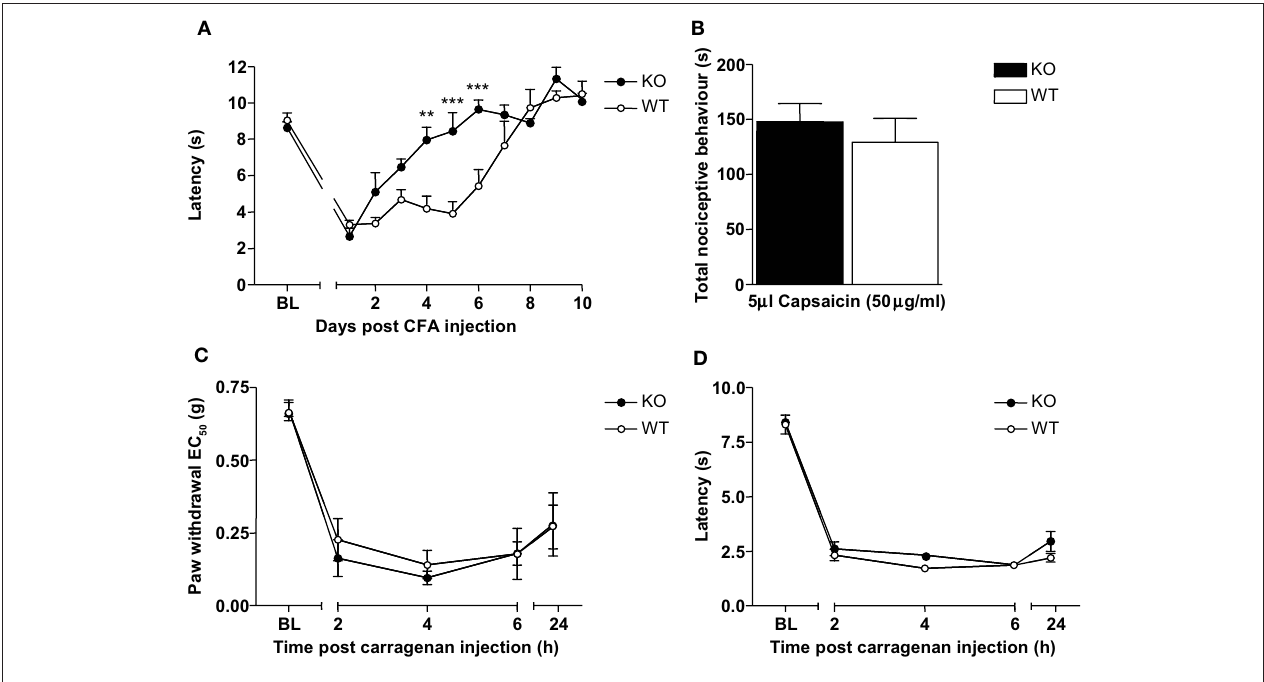
FIGURE 3 | Glra3 − / − mice display attenuated CFA behaviour, but show no differences in other infl ammatory models. (A) Paw withdrawal latencies following unilateral intraplantar CFA (20 µl) were signifi cant versus contralateral responses for wild-type mice days 1–6 and days 1–3 for Glra3 − / − mice ( p < 0.001). Paw withdrawal latencies of Glra3 − / − mice were signifi cantly different from wild- type mice at days 4 ( p < 0.01, **), 5 and 6 ( p < 0.001, ***) ( Glra3 − / − , n = 7; wild type, n = 5). (B) Total nociceptive behaviour following unilateral intraplantar